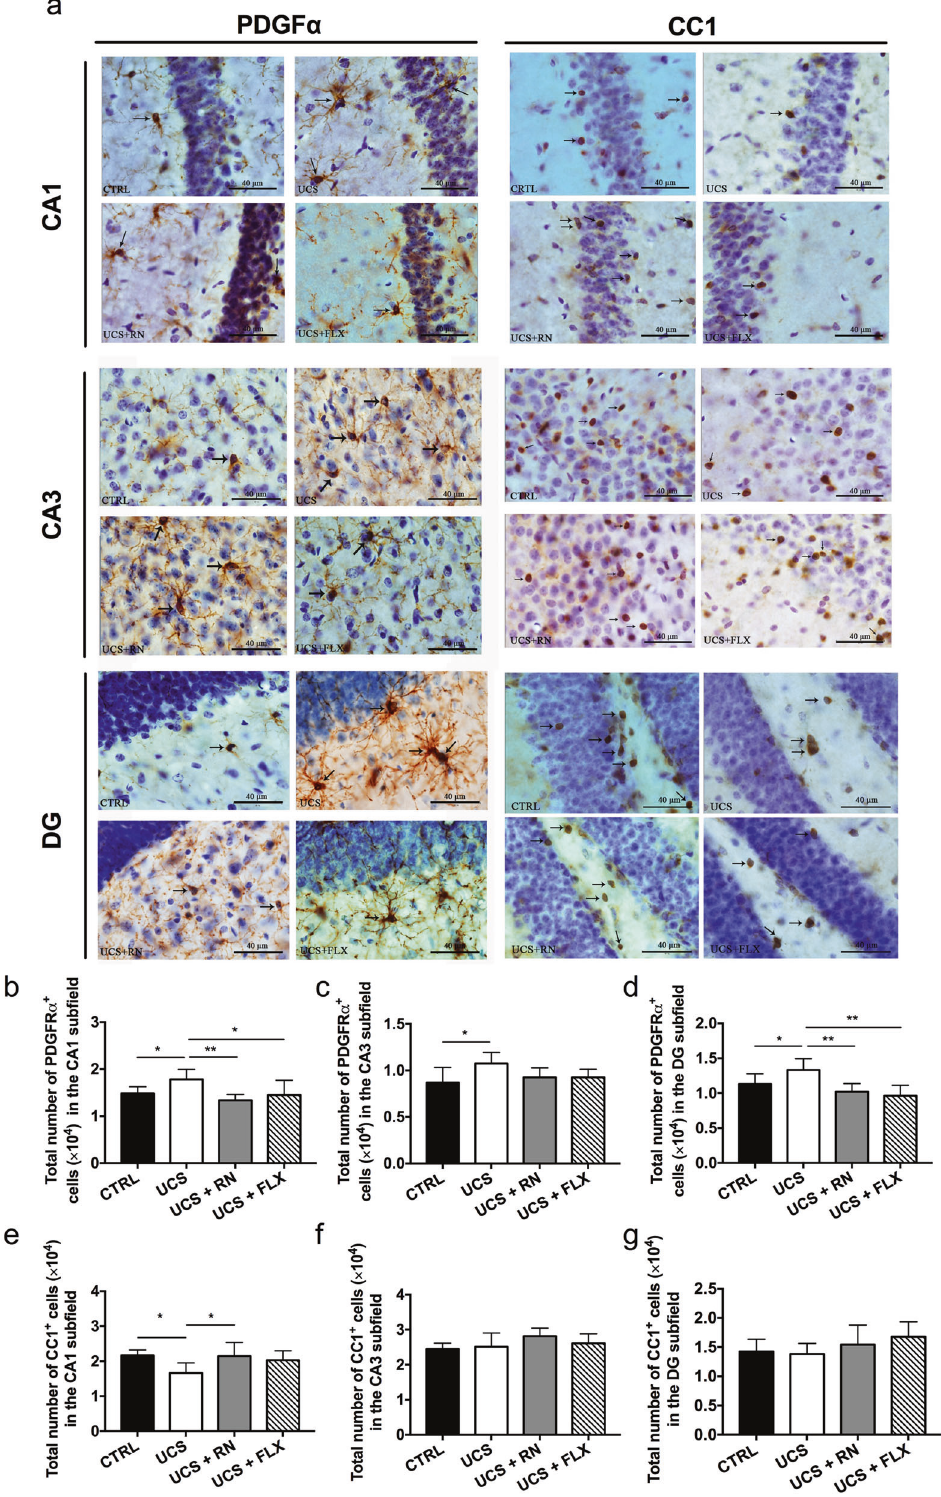
Fig. 3 The effects of running exercise and fl uoxetine on the mature oligodendrocytes and OPCs of the hippocampus. a Immunohistochemical staining with an anti-PDGF α antibody and anti-CC1 antibody in the CA1, CA3, and DG hippocampal sub fi elds of mice in the CTRL group, UCS group, UCS + RN group, and UCS + FLX group. The black arrows indicate the PDGF α + cells or the CC1 + cells. Scale bar = 40 μ m. b – d The numbers of PDGF α + OPCs in the CA1, CA3, and DG hippocampal sub fi elds of mice in the CTRL group, UCS group, UCS + RN group, and UCS + FLX group ( n = 5 for each group). e – g Stereological analyses of the CC1 + cells in the CA1, CA3, and DG hippocampal sub fi elds of mice in the CTRL group, UCS group, UCS + RN group, and UCS + FLX group ( n = 5 for each group). All data are shown as the means ± SDs, * P < 0.05 and ** P <